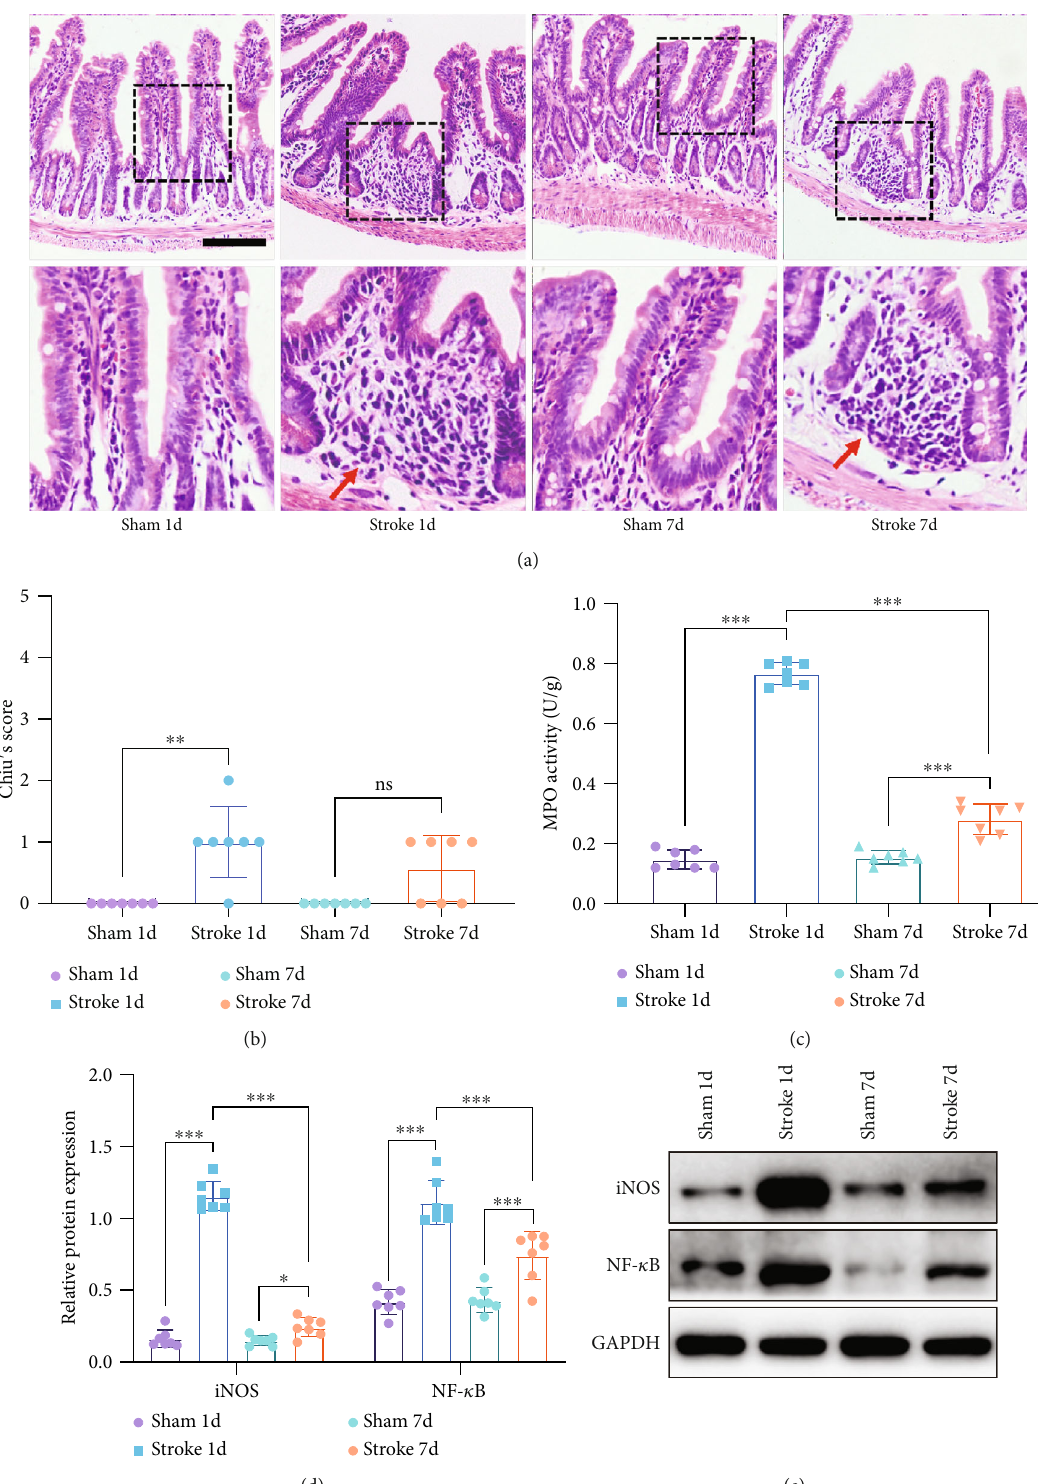
Figure 3: Stroke caused intestinal in fl ammation. (a) Representative images of hematoxylin-eosin (HE) staining of the ileum (magni fi cation × 200, red arrow points to the leukocyte in fi ltration). (b) Chiu ’ s score for the intestinal mucosa ( n = 7 ) (Kruskal-Wallis ANOVA on ranks). (c) Myeloperoxidase (MPO) activity was measured ( n = 7 ) (two-way ANOVA with Tukey ’ s multiple comparison test). (d, e) Representative western blots and quanti fi cation data of iNOS, NF- κ B, and GAPDH for each group ( n = 7 ) (two-way ANOVA with Tukey ’ s multiple comparison test). Data were expressed as mean ± standard deviation . ∗ p < 0 : 05 , ∗∗ p < 0 : 01 , and ∗∗∗ p < 0 : 001 . ns: not signi fi cant. Scale bar: 100 μ